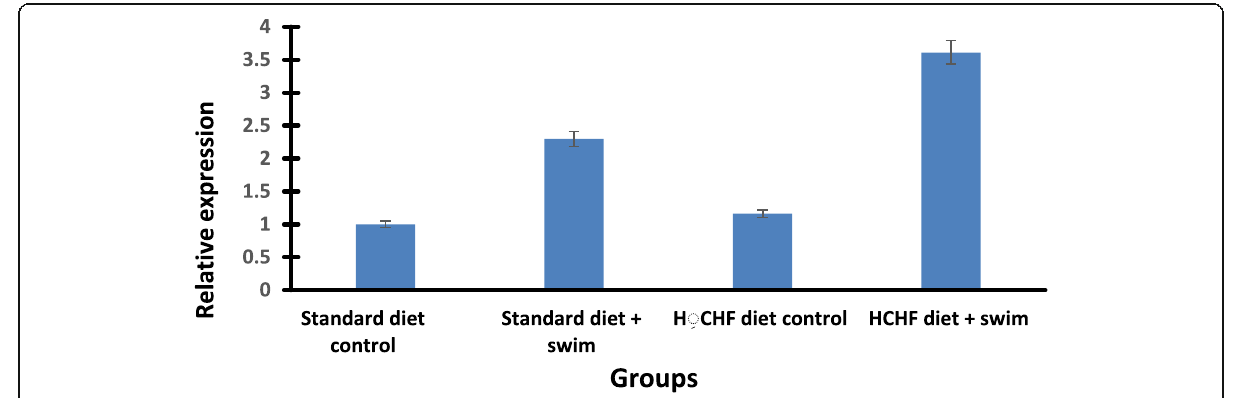
Fig. 2 Relative fold change of muscle PGC-1 α mRNA expression in different studied